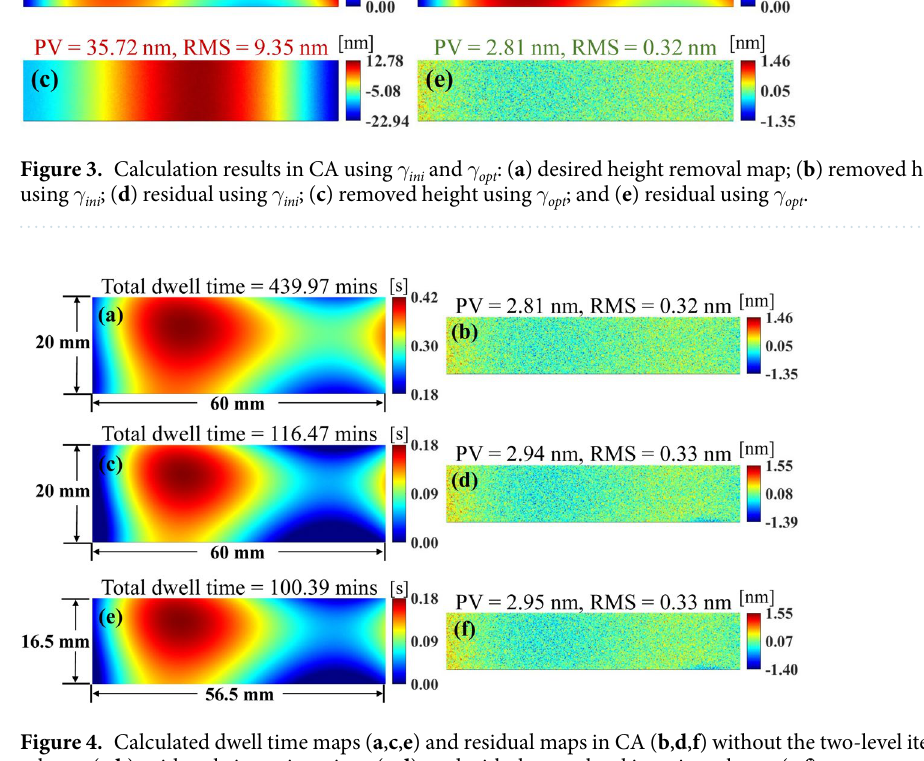
Figure 4. Calculated dwell time maps ( a , c , e ) and residual maps in CA ( b , d , f ) without the two-level iterative scheme ( a , b ), with only inner iterations ( c , d ), and with the two-level iterative scheme ( e , f